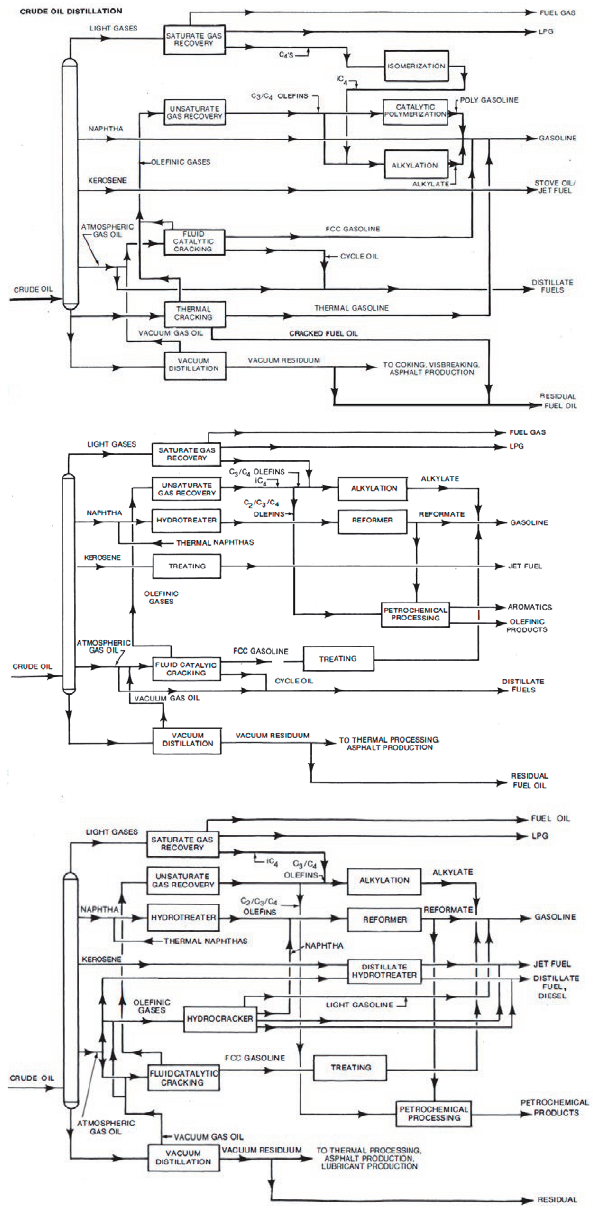
Figure 6. Refinery Configuration Evolution in 1940, 1950 and 1970. Reproduced from U.S. Petroleum Refining: Meeting Requirements for Cleaner fuels and Refineries. Appendix C. History and Fundamentals of Refining Operations, National Petroleum Council, 1993